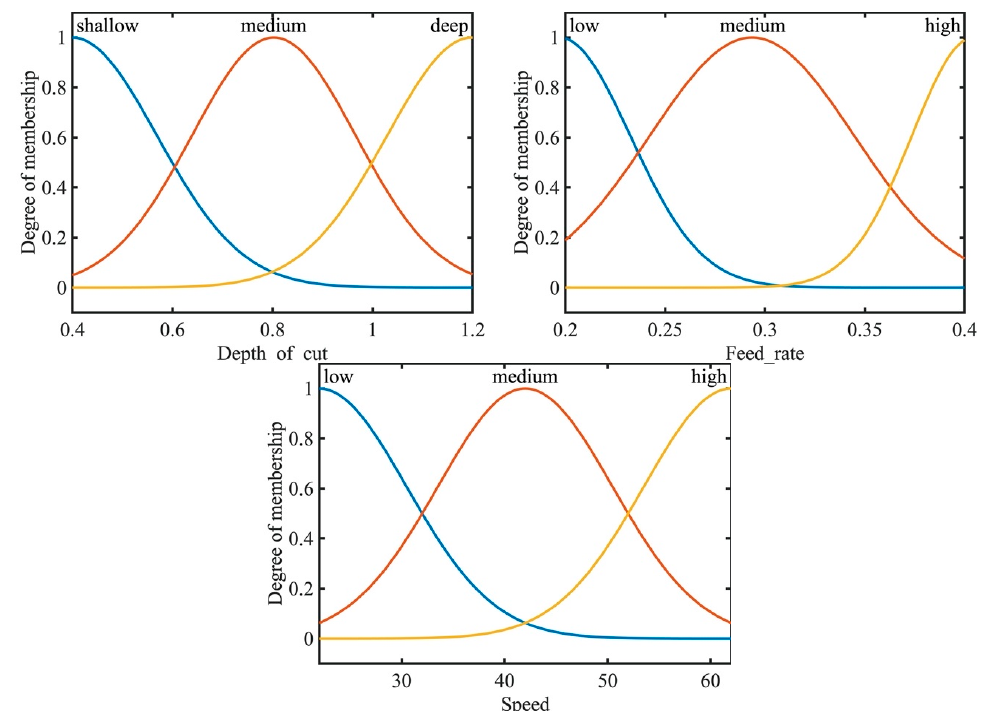
Figure 4. Takagi-Sugeno fuzzy inference engine Gaussian membership functions for the dry turning process. Table 5. QPSO simulation parameters with the ANFIS system for the dry turning process.